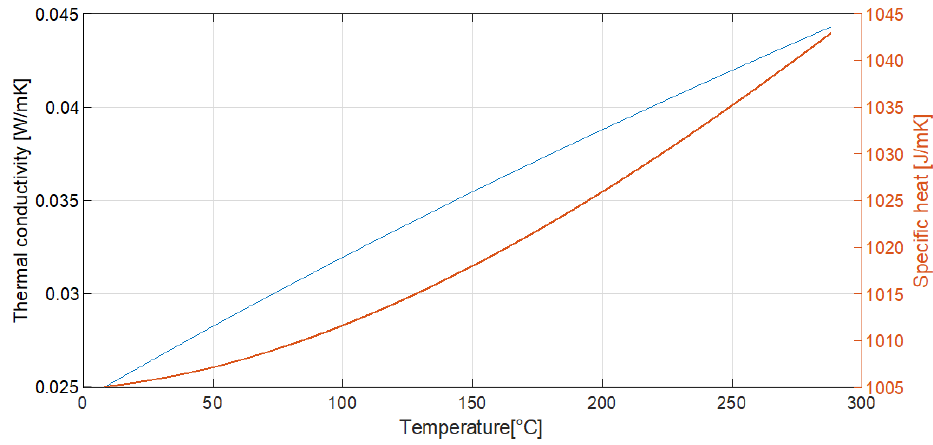
Figure 9. Air thermal properties.